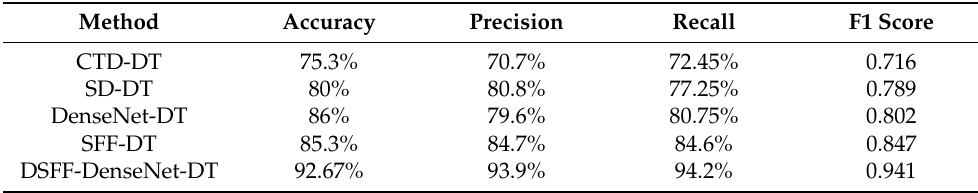
Table 8. Comparison of DSFF-DenseNet-DT with other different methods in terms of accuracy, precision, recall and F1 score.